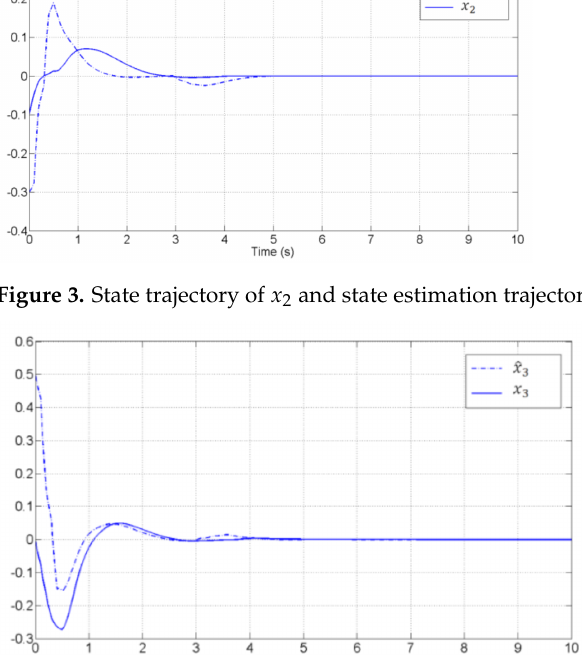
Figure 4. State trajectory of x 3 and state estimation trajectory ˆ x 3